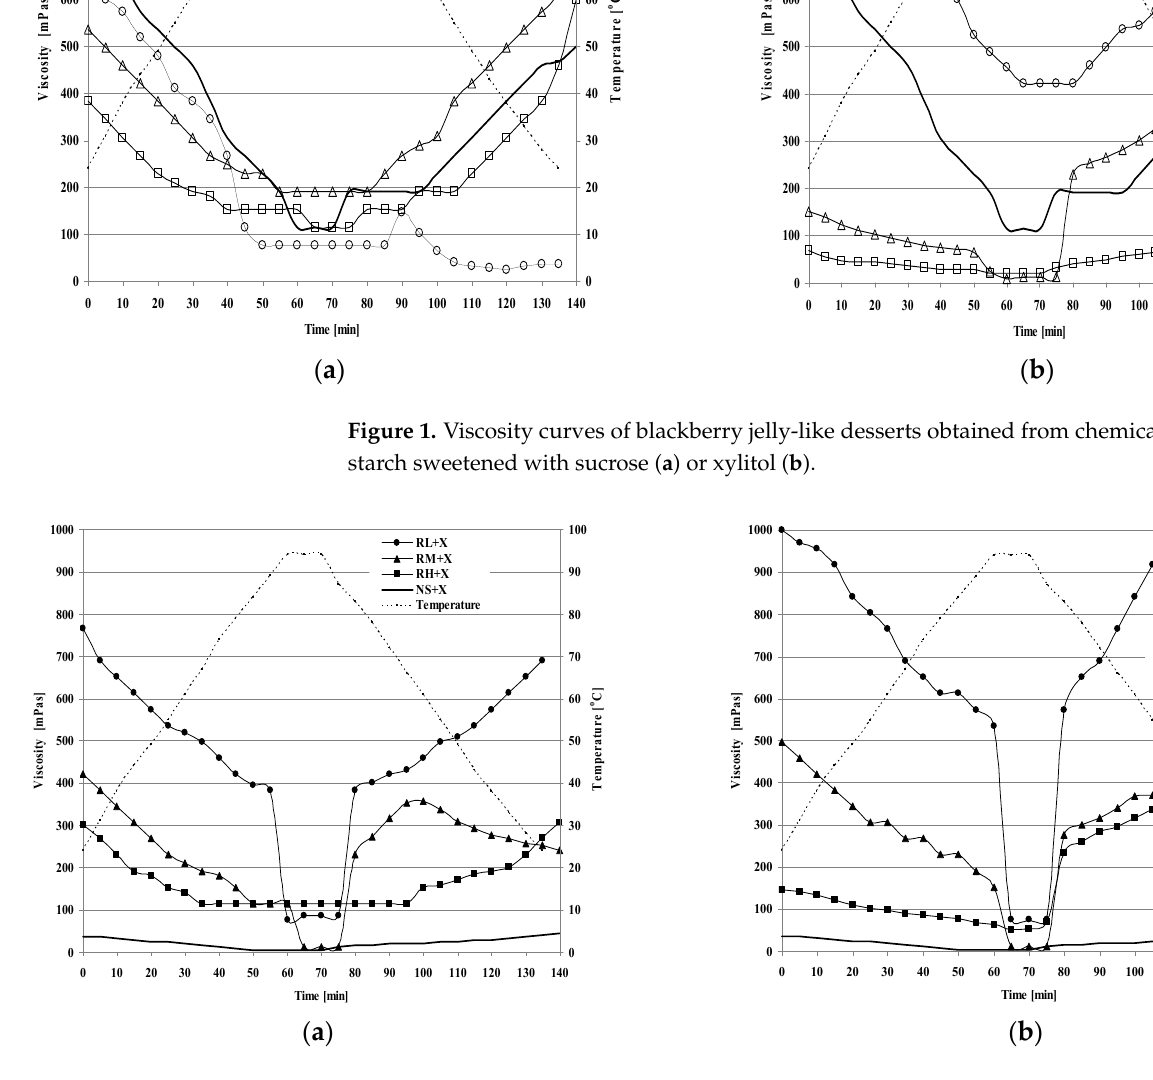
Figure 2. Viscosity curves of blackberry jelly-like desserts obtained from physically modified corn starch sweetened with sucrose ( a ) or xylitol ( b ). Table 1. Parameters of the viscosity change of blackberry jelly ‐ like desserts.